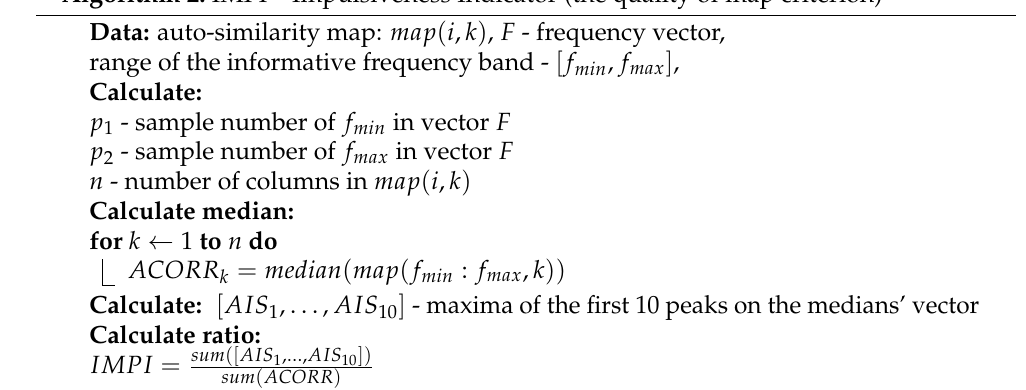
Algorithm 2: IMPI—Impulsiveness Indicator (the quality of map criterion)